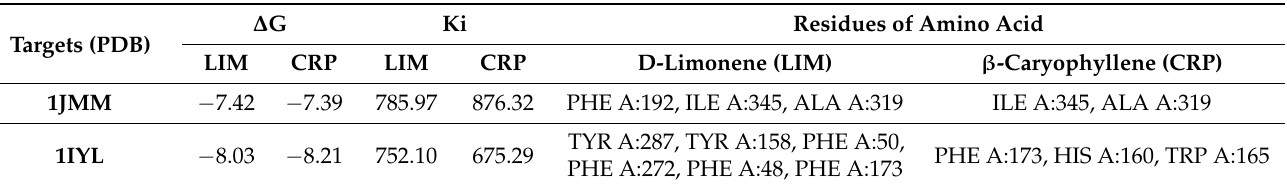
Figure 3. Time-kill assays of C. albicans . Table 3. Binding energy ( ∆ G; kcal/mol) and inhibition constant (Ki; µ M) for limonene (LIM) and caryophyllene (CRP) with target